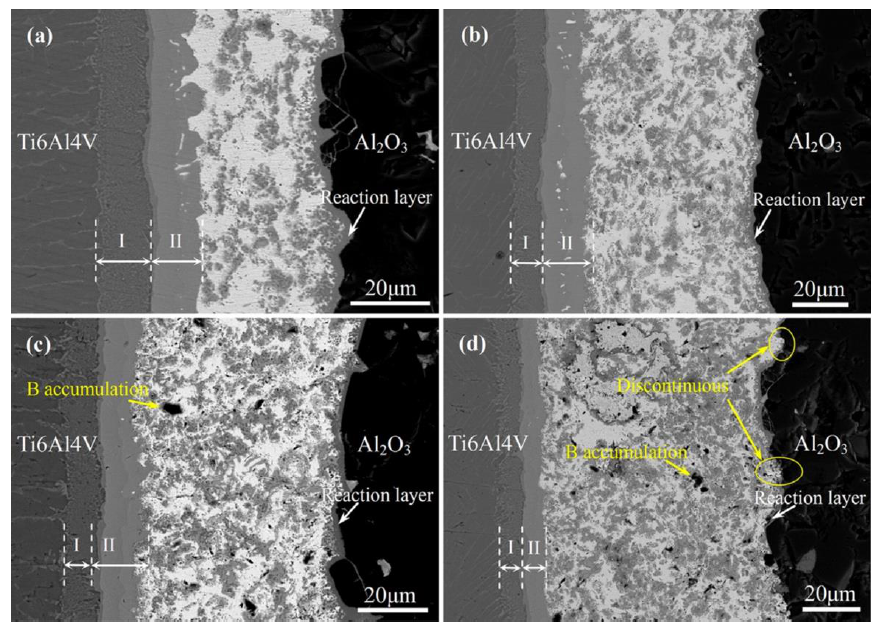
Figure 5. Microstructure of Ti6Al4V/Al 2 O 3 joint brazed with Ag-Cu with different B content at 880 °C for 10 min: ( a ) 0.2; ( b ) 0.5; ( c ) 1.0 and ( d ) 1.5 wt%., reproduced from Reference [26] with permission of Elsevier, 2016.